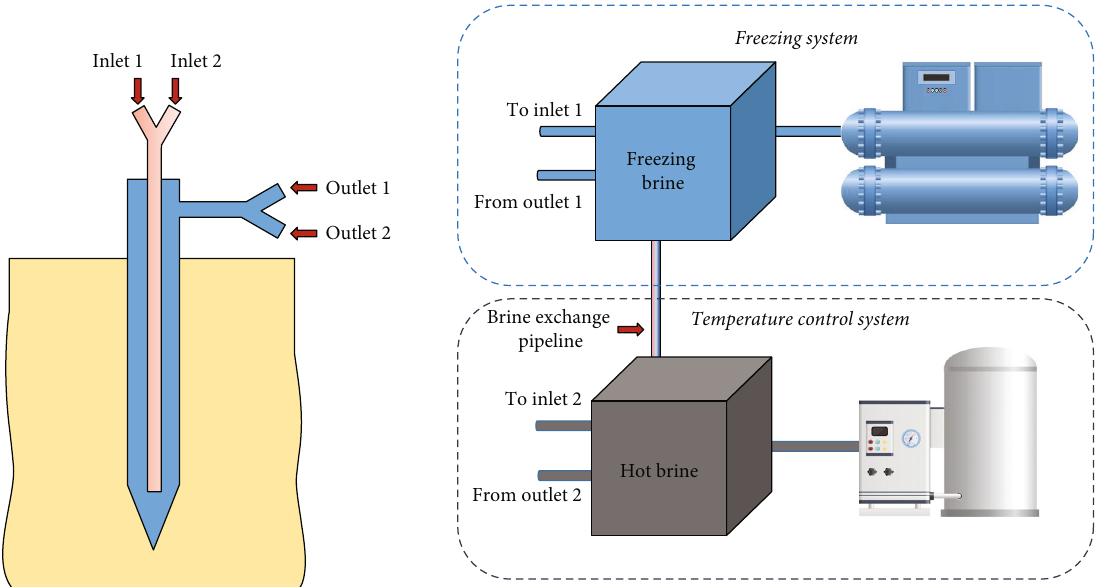
Figure 13: The dual-circuit liquid supply